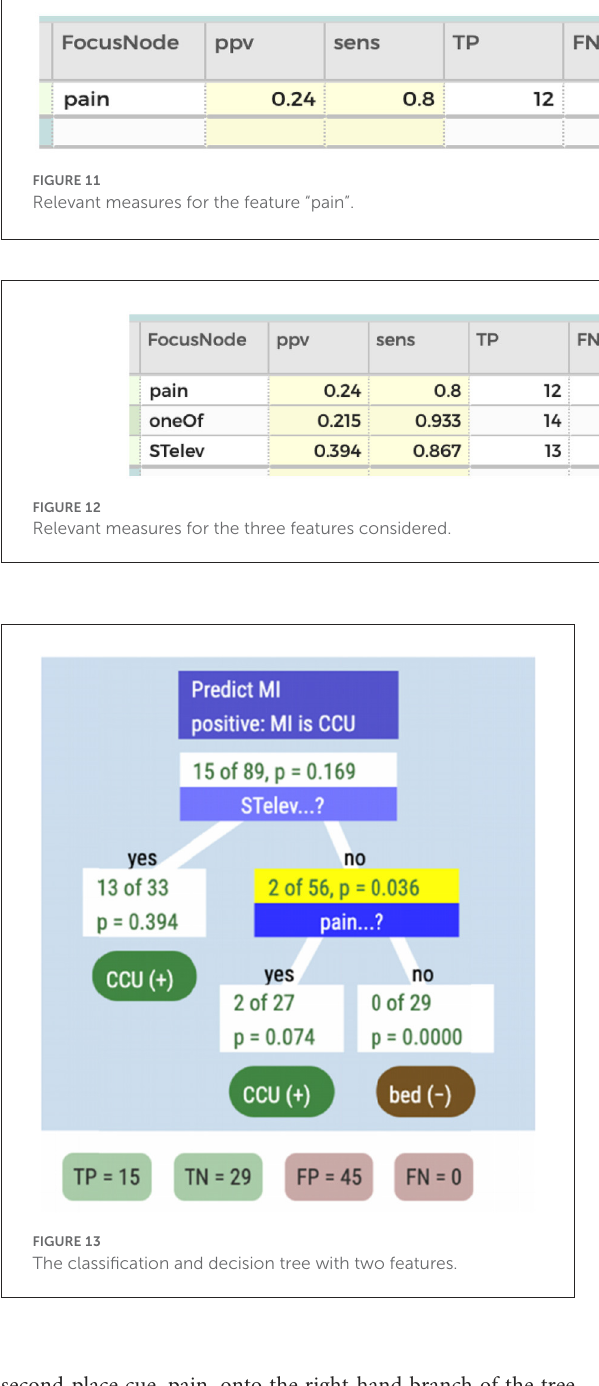
second-place cue, pain, onto the right-hand branch of the tree (Figure 13).